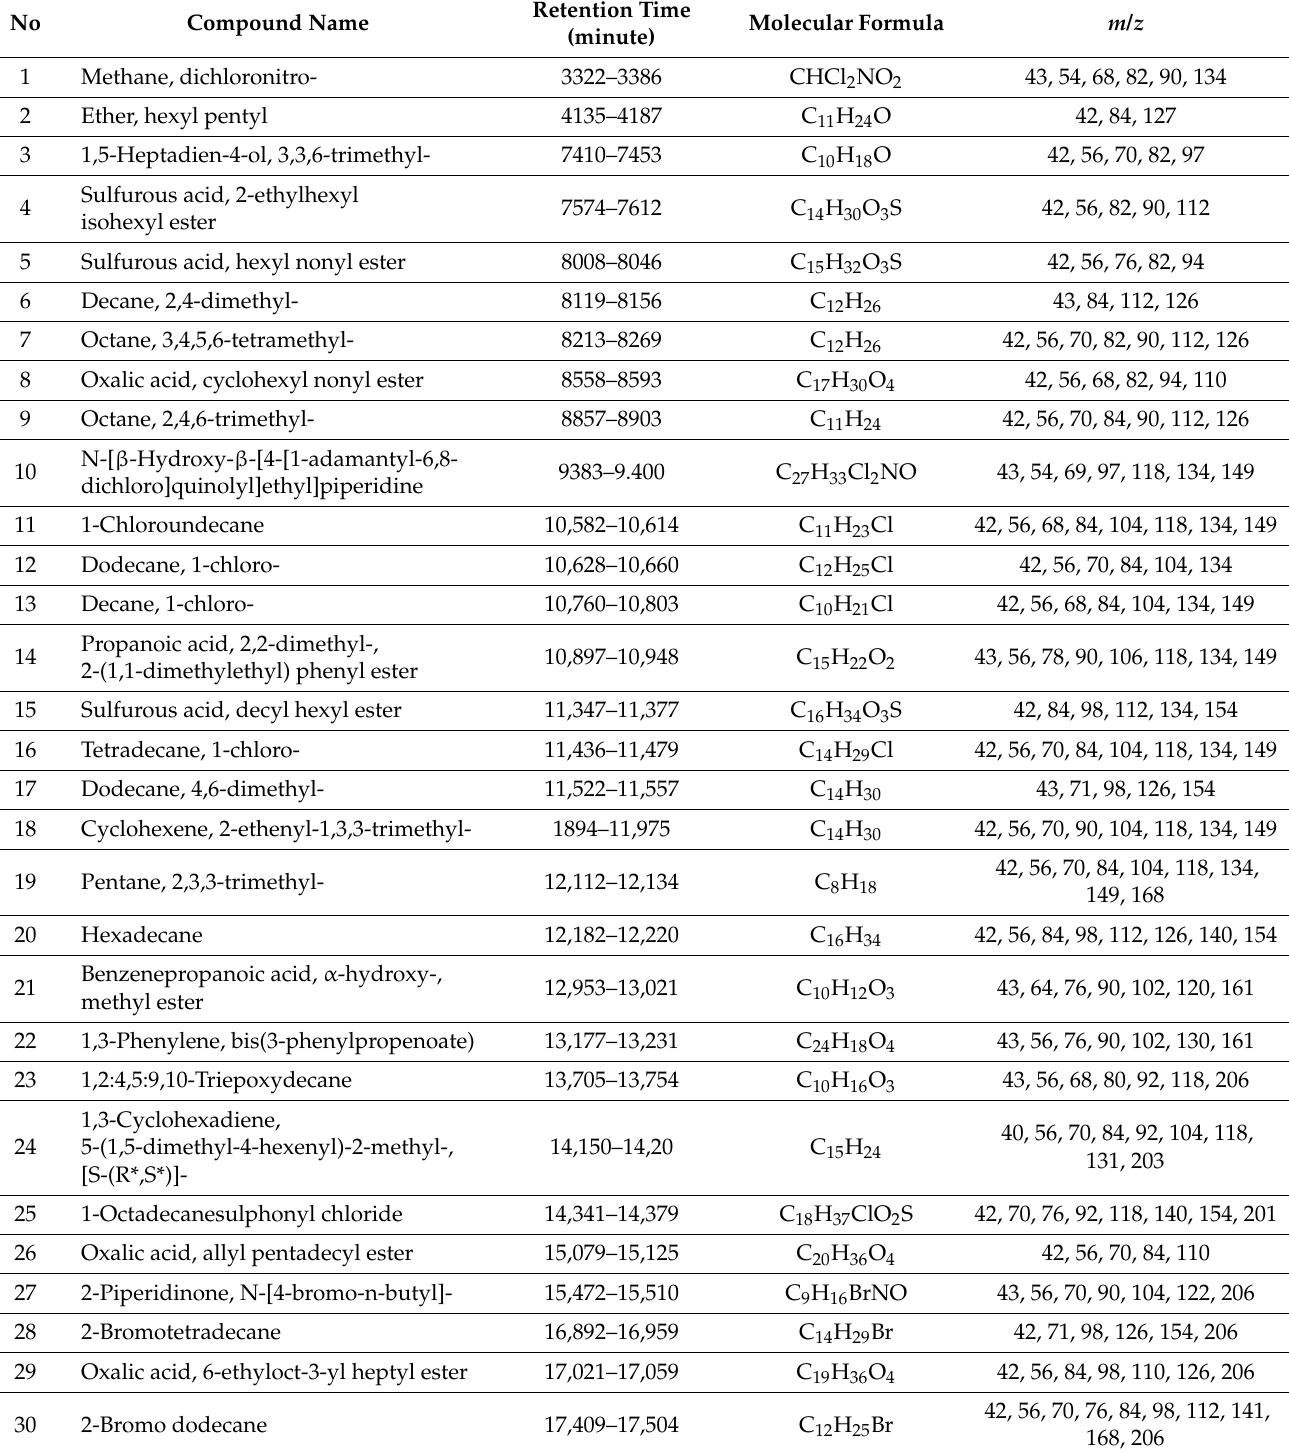
Table 1. Metabolite profiling of B. cernua methanol extract using gas chromatography/mass spec- trometry (GC–MS)